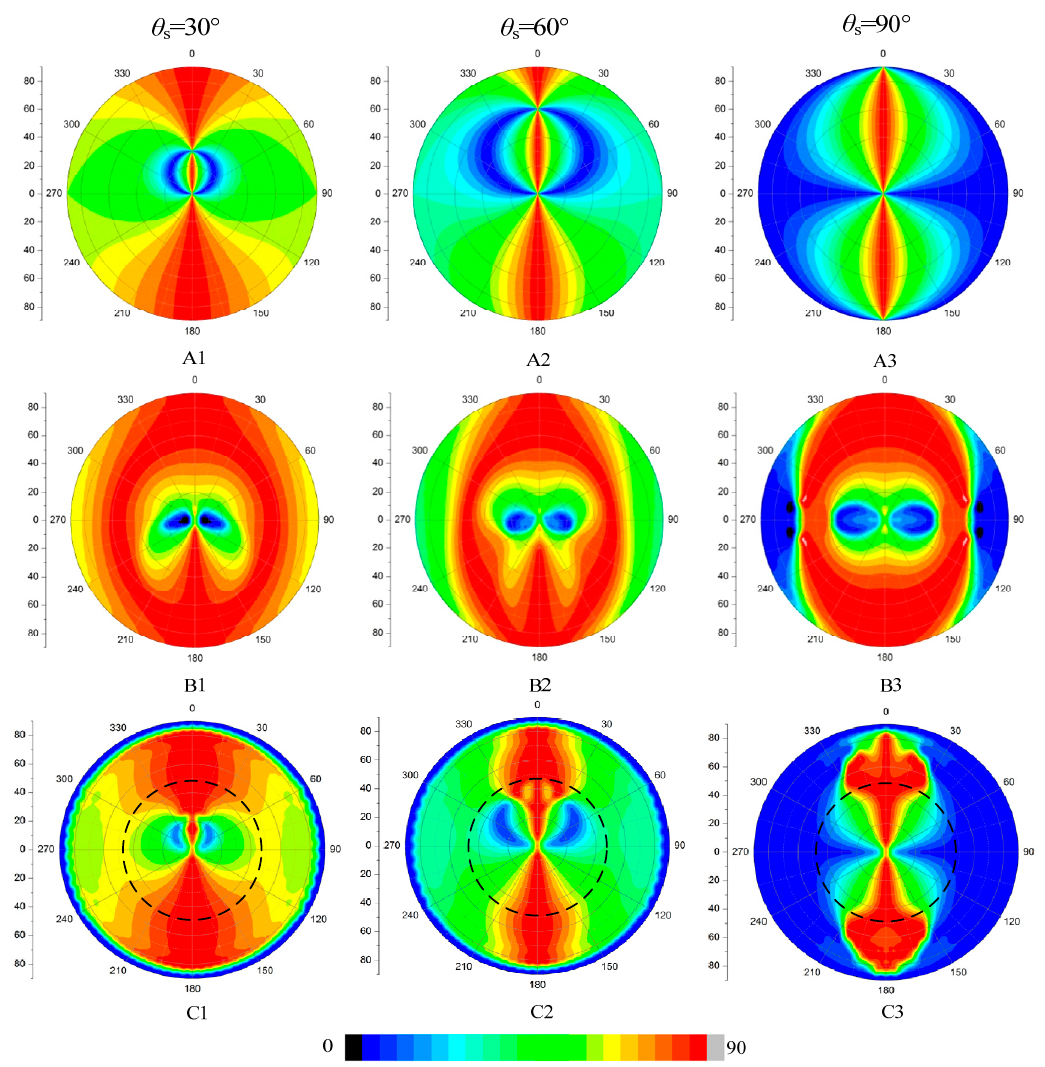
Figure 13. The AOP patterns of the: skylight ( A ); reflected light ( B ); and refracted light ( C ) under different SZAs (30°, 60° and 90°), where the wind speed is 5 m/s, and wind direction is 0°.